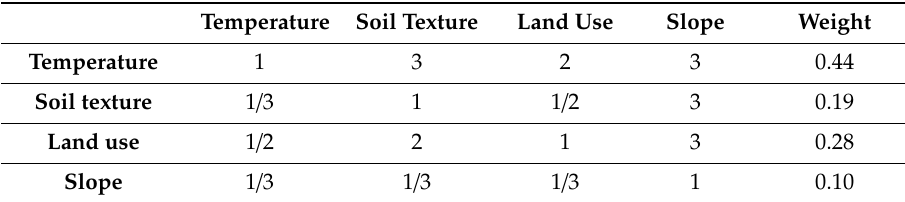
Table 4. Main criteria rating based on the pairwise comparison